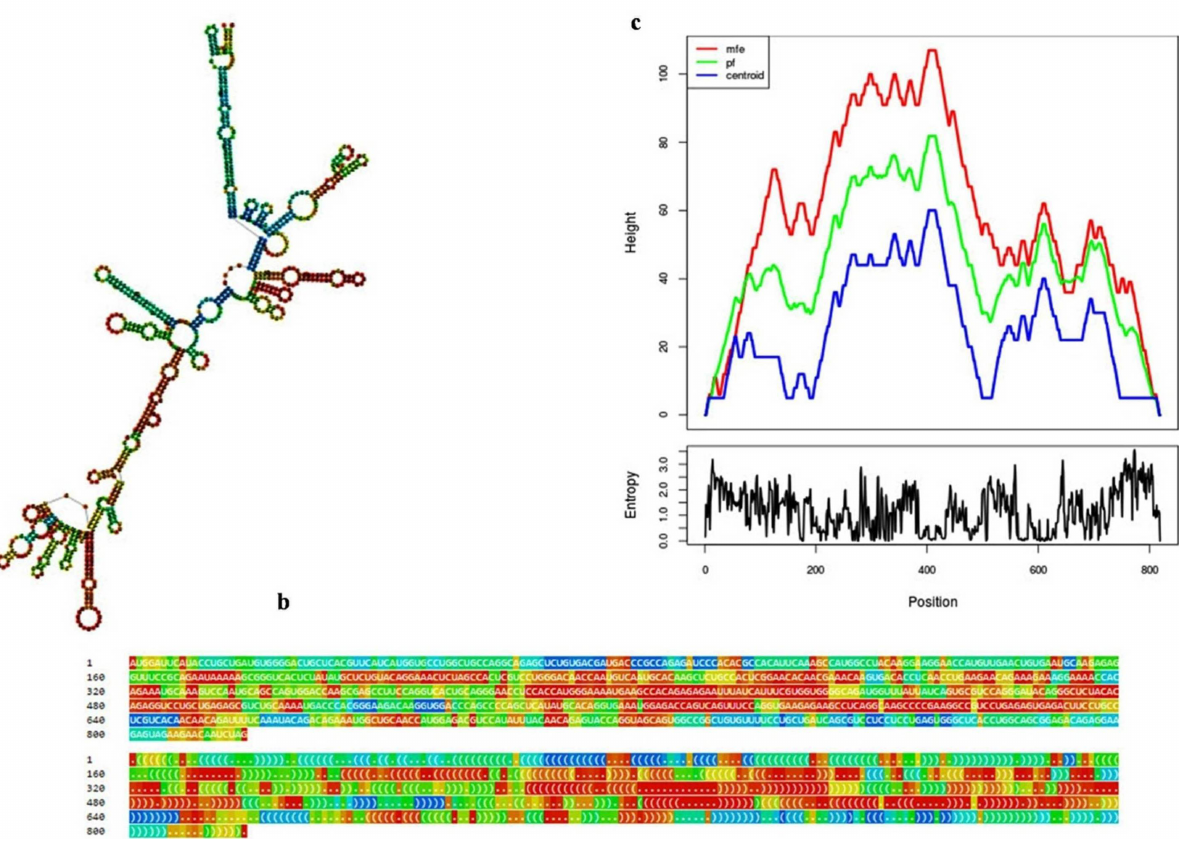
Figure 1: (a) The MFE secondary structure, (b) the base-pairing probability and (c) the mountain plot for CD25 (the MFE structure (red), the thermodynamic ensemble of RNA structures (green) and the centroid structure (blue)) were obtained. Under the mountain plot, positional entropy was